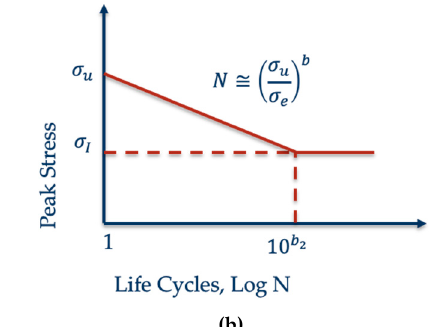
Figure 5. ( a ) Evolution of weight loss on experimental rain erosion testing coupons and lifetime prediction model defining the incubation period and mass removal rate ( b ) Springer Model based Fatigue life N approximation related with the material ultimate strength 𝜎 u , the parameter “erosion strength”, 𝜎 e and the parameter b that includes the fatigue knee at the endurance limit 𝜎 I . Adapted from: [13]